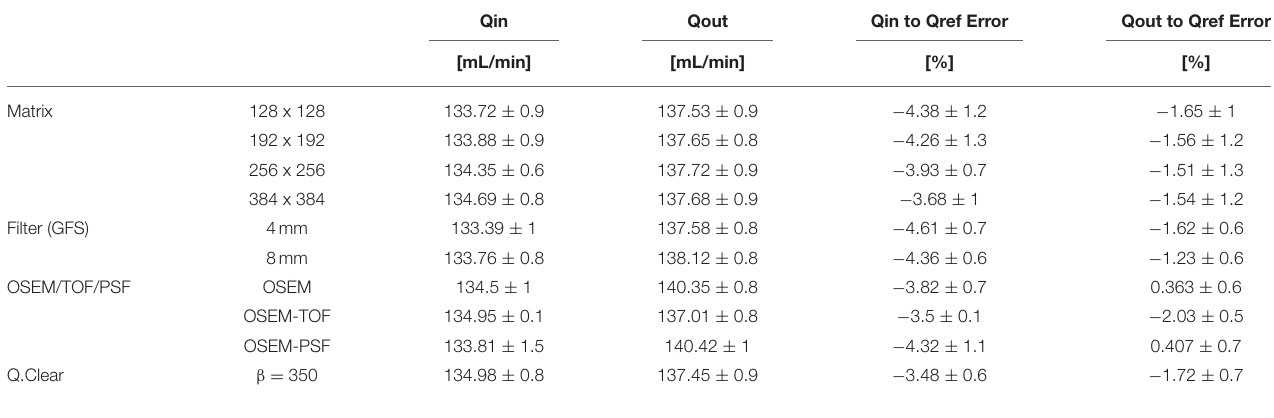
TABLE 3 | The mean and SD values for the Qin and Qout flow values and for their relative differences with respect to the reference flow Qref (mean Qref = 140 mL/min) over all the subsequent measurements for all the